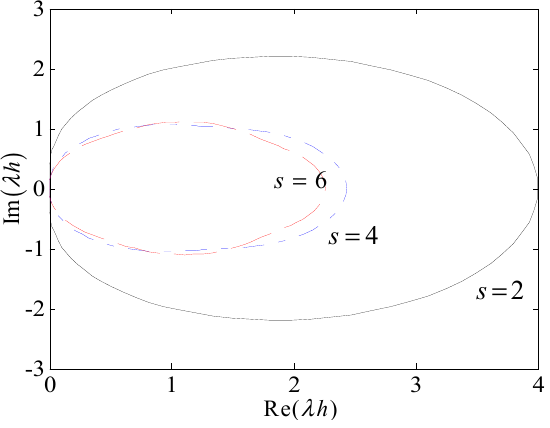
Figure 1. Stability region of new linear multistep formulae (LMF) for even numbers of s.